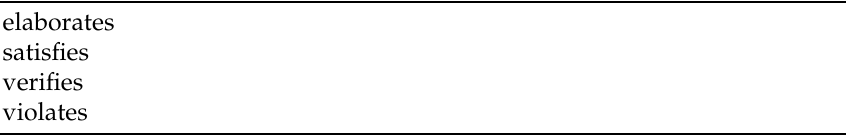
Table 2. OSLC relations (with PREFIX oslc) supported in our